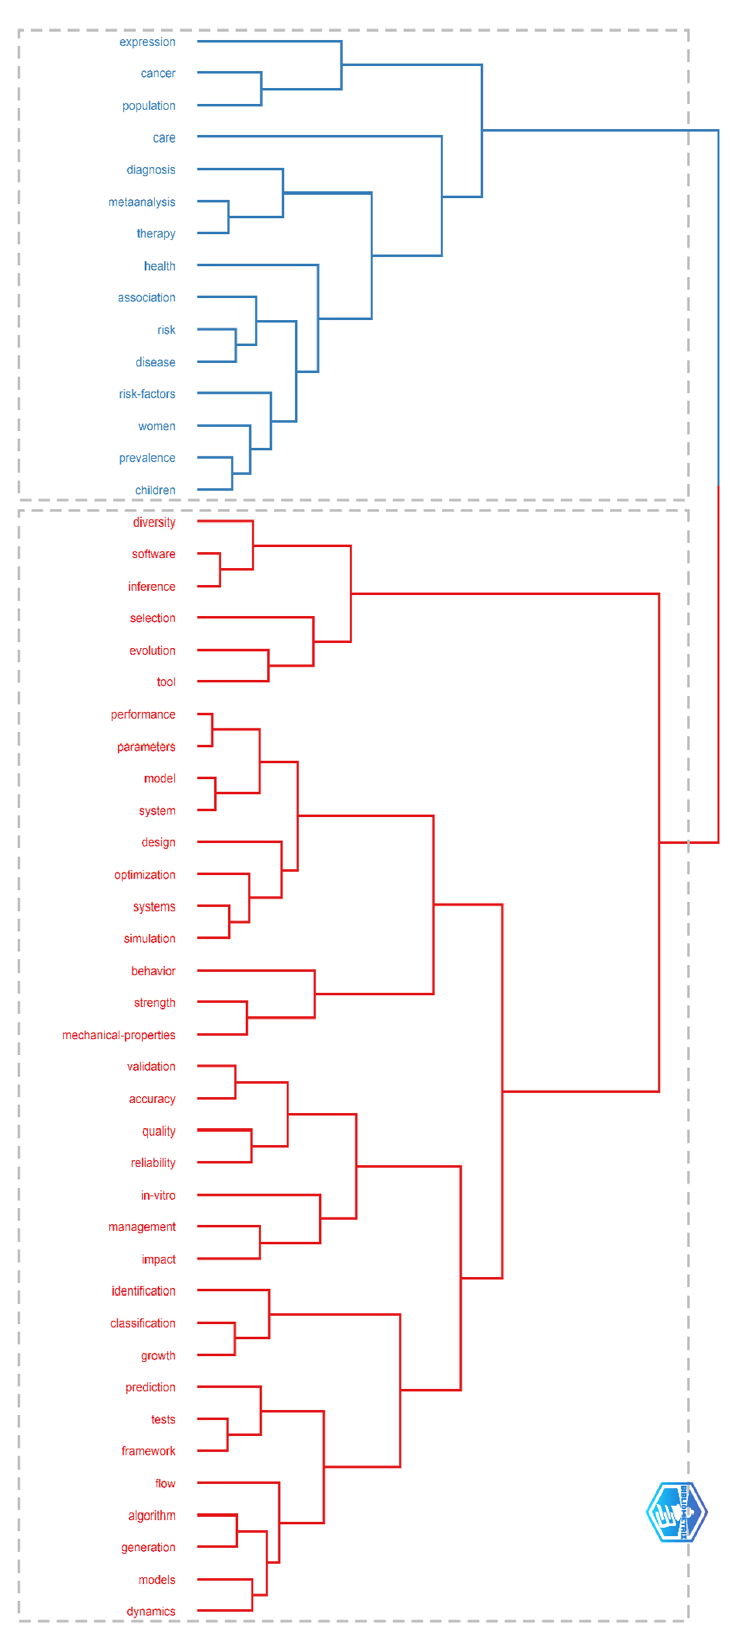
Figure 20. Topic Dendrogram for the years 2016–2018.